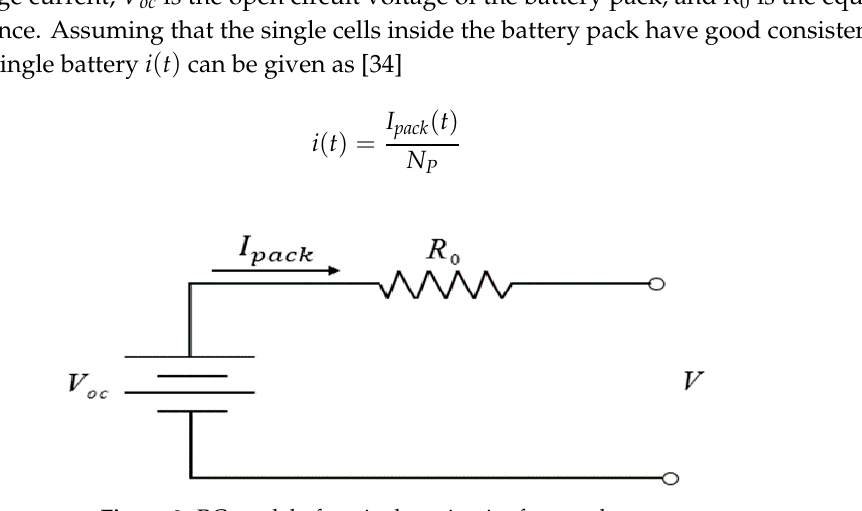
Figure 3. RC model of equivalent circuit of power battery.